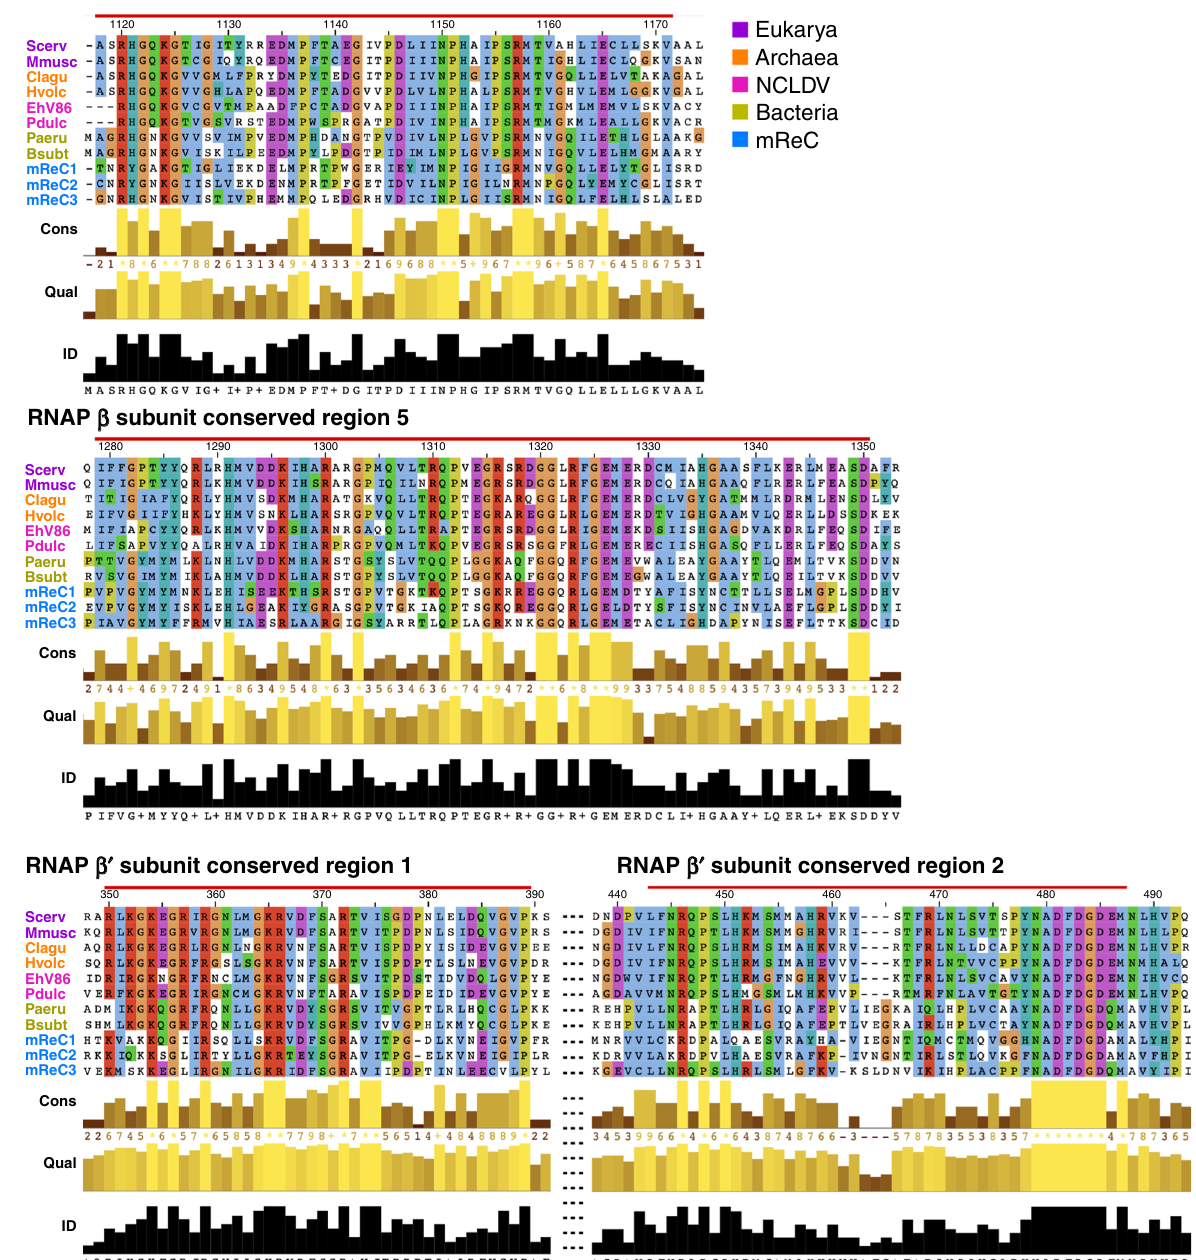
Fig. 3 Highly conserved regions of the RNAP β - and β ′ -subunits alignment conserved across taxa. Eukarya homologs RPB2 and RPB1, Archaea homologs B and A, were used for β and β ′ , respectively. Scerv ( S. cerevisiae ), Mmusc ( Mus musculus), Clagu ( Caldisphaera lagunensis ), Hvolc ( Haloferax volcanii ),